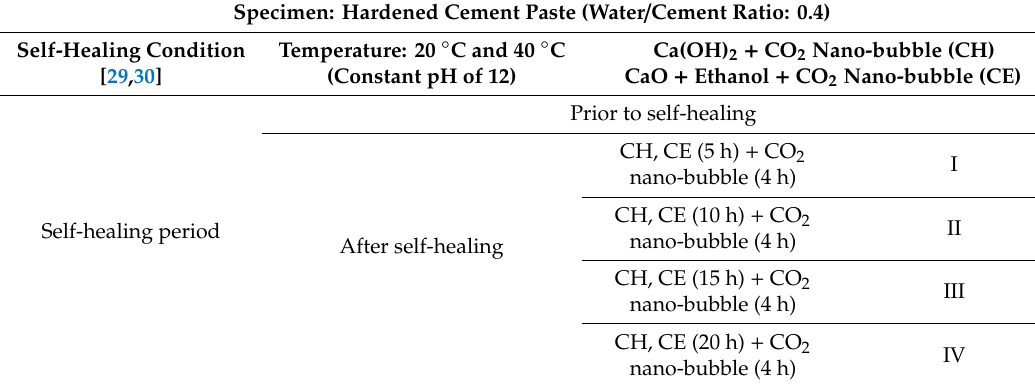
Table 1. Experimental factors and conditions.